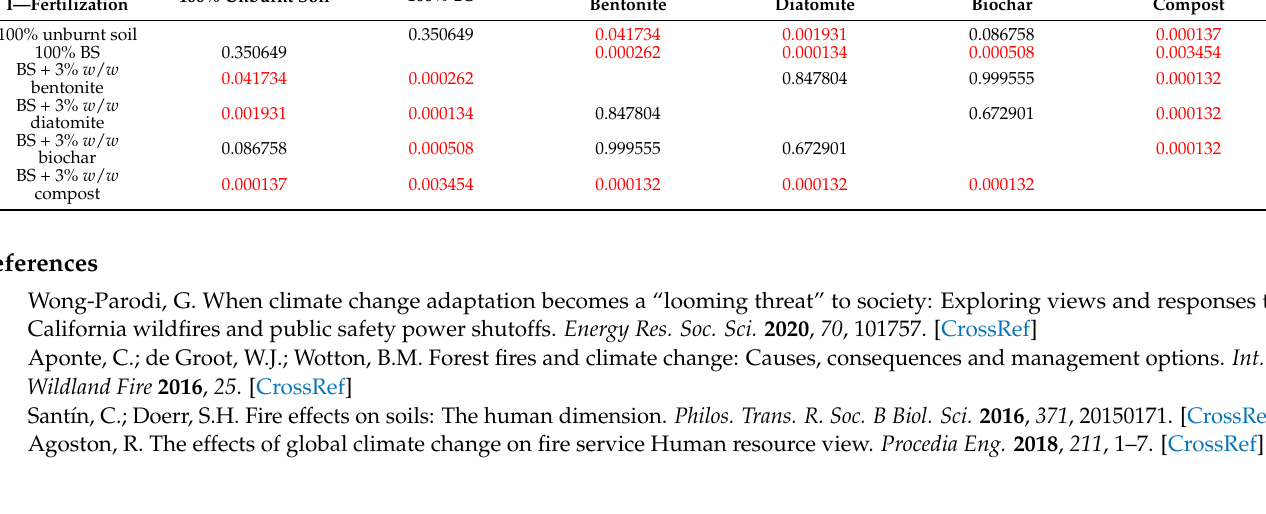
Figure A2. Graphical illustration of the effect of individual factors on the underground (root) biomass yield.